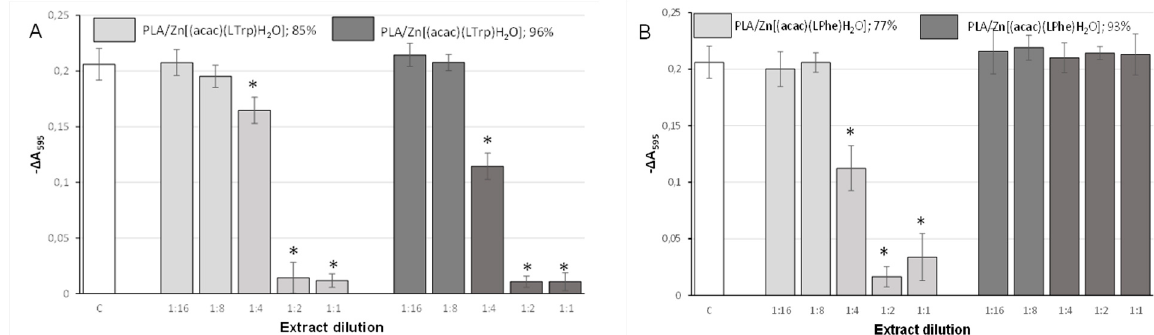
Figure 10. Resazurin reduction by CCD-11Lu fibroblasts incubated with extracts of polylactides initiated using ( A ) Zn[(acac)(LTrp)H 2 O]; and ( B ) Zn[(acac)(LPhe)H 2 O]. Percentages describe the total conversion rate, and each bar represents the mean ± SD; * p < 0.05 compared to the control.